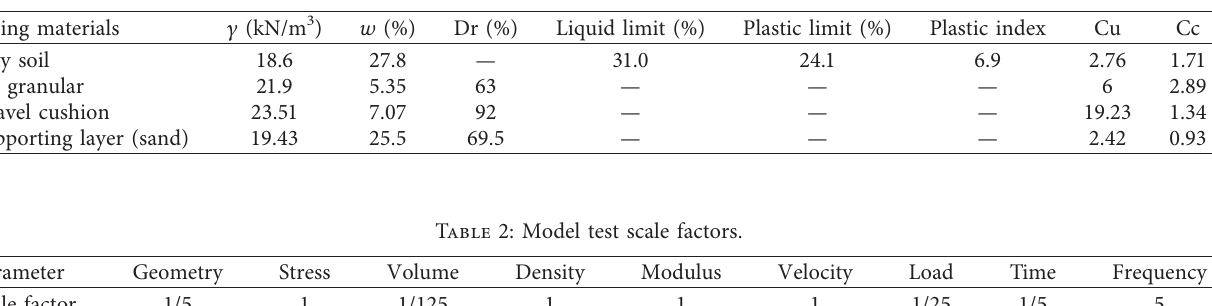
Figure 3: Particle size distributions of geomaterials in ballastless railways. Table 1: Physical properties and parameters of geomaterials used.